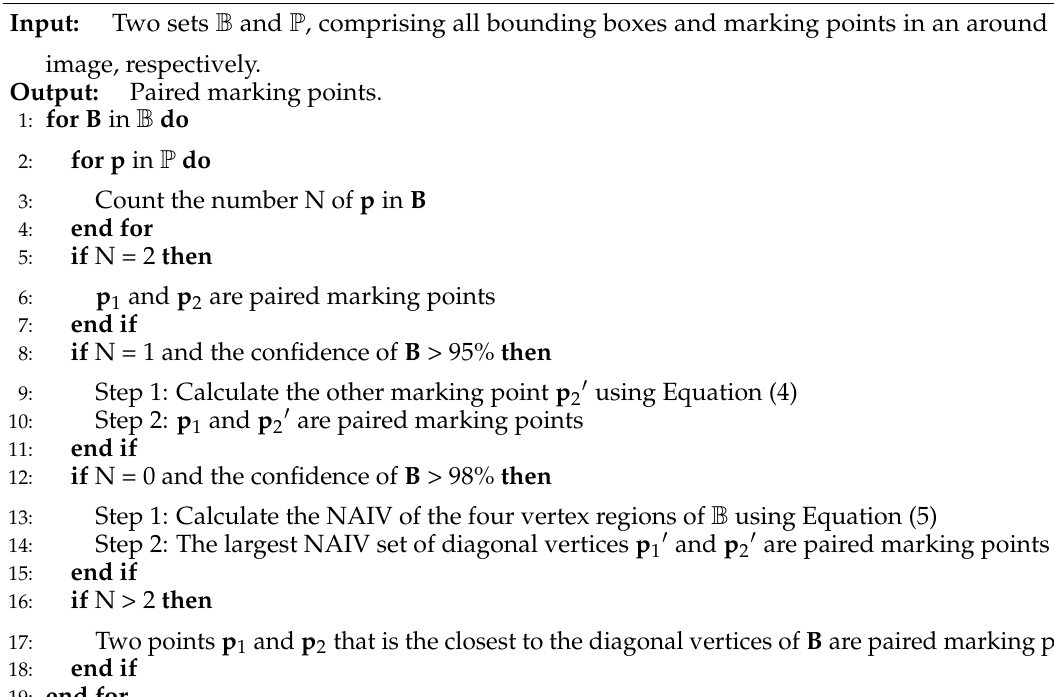
Algorithm 1 Rules of paired marking points